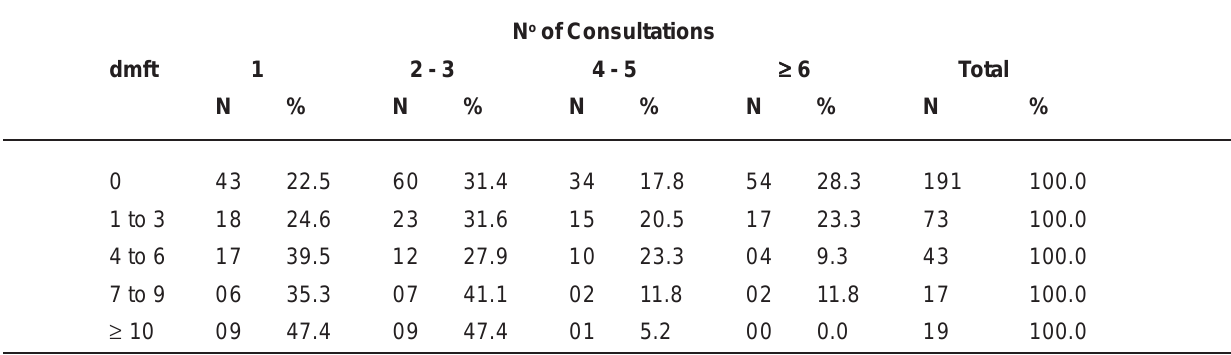
TABLE 2- dmft Index values and the number of consultations provided in a Preventive Program for Pregnant Mothers and Babies. Federal University of Piauí, 2005